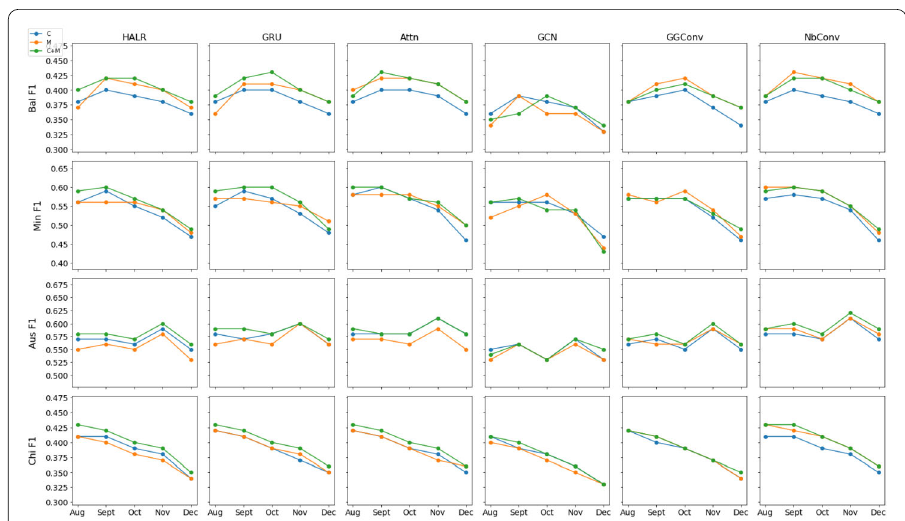
Figure 3 Monthly F1 scores for predicting next-day property crime hotspots. Each row represents the F1 scores for one city across all predictive models: Baltimore (Bal), Minneapolis (Min), Austin (Aus) and Chicago (Chi). The blue lines represent F1 scores for models with only crime data ( C ); the orange lines represent F1 scores for models that use only mobility data ( M ) and the green line are F1 scores both models that use both ( C + M )